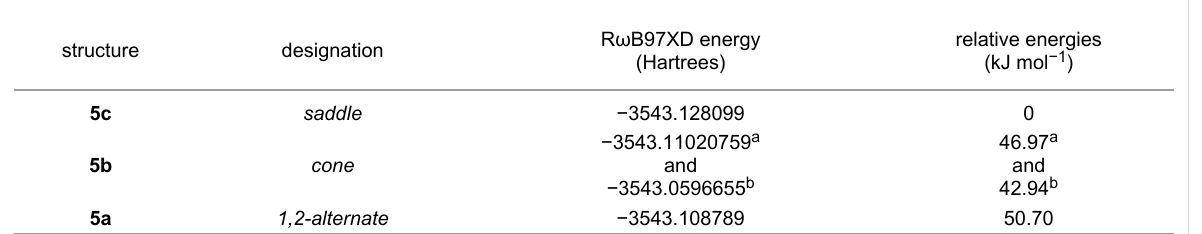
Table 2: DFT computed energy values for the three different conformations of 5 .